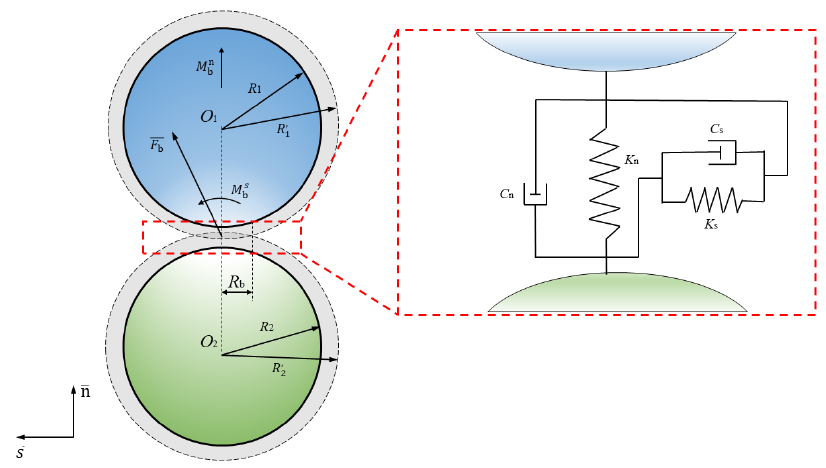
Figure 5. Contact model between frass particle s.